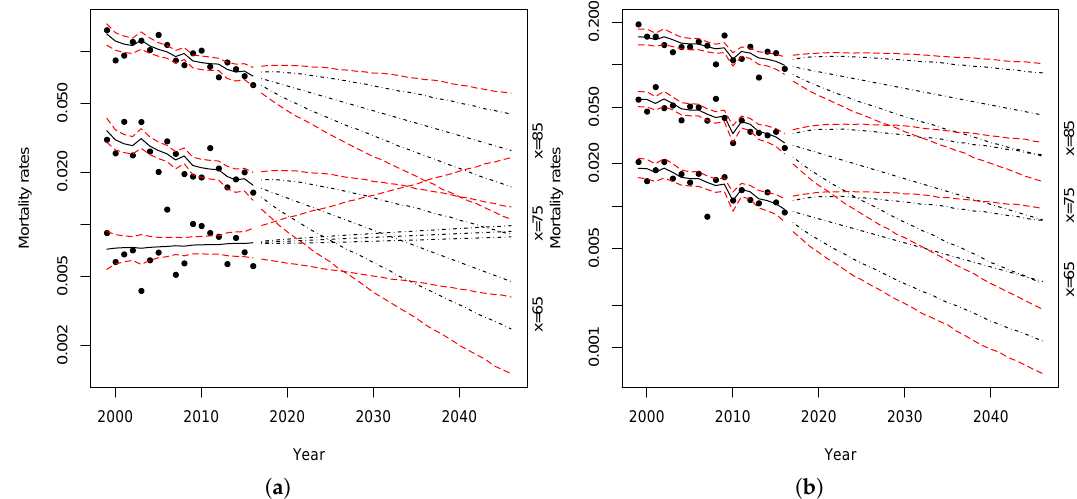
Figure 17. Mortality rate projections at age 65, 75, 85 with parameters uncertainly with Lee–Carter model for ( a ) female Maltese population, ( b ) male Maltese population.